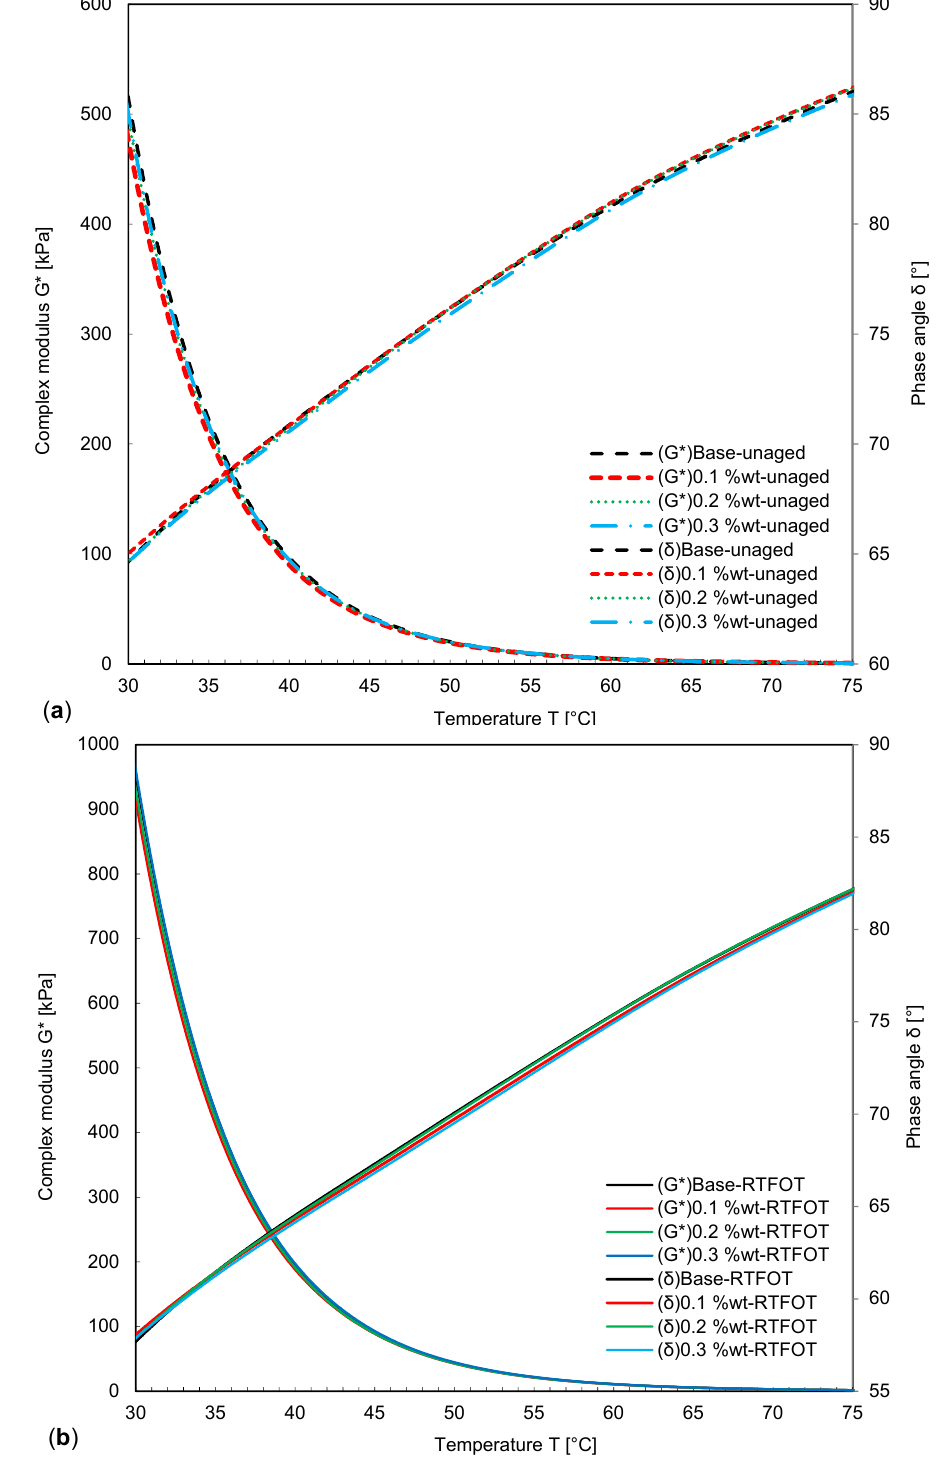
Figure 6. Complex modulus and phase angle of bitumen modified with NPs: ( a ) before and ( b ) after short-term laboratory aging.